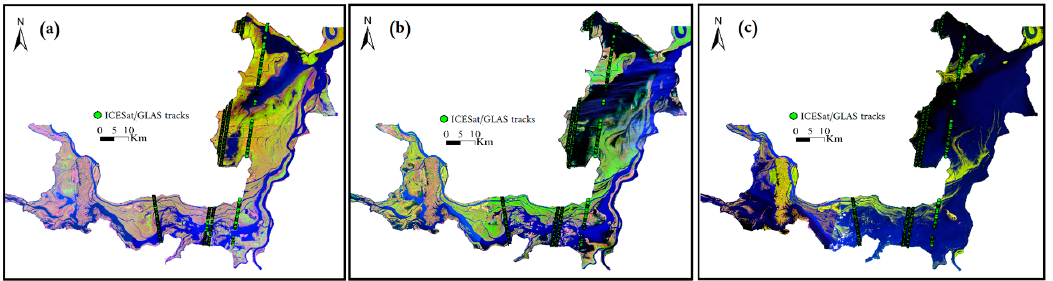
Figure 3. Intersections of ICESat/GLAS with lake boundaries at different water levels in the Dongting Lake area: ( a ) low water level, ( b ) high water level.